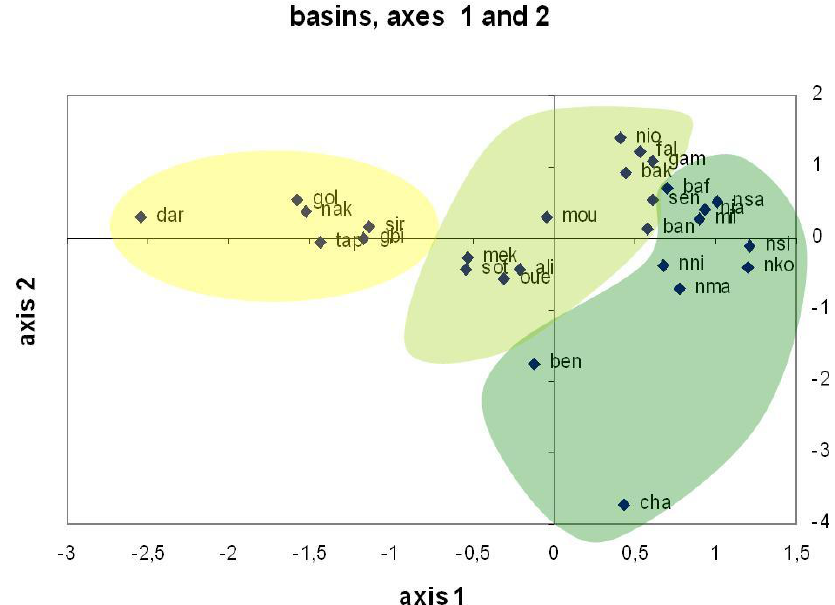
Figure 12. Sample space of the PCA, axes 1 and 2. Sahelian and north-Sudanian is yellow, Sudanian is light green and Guinean is dark